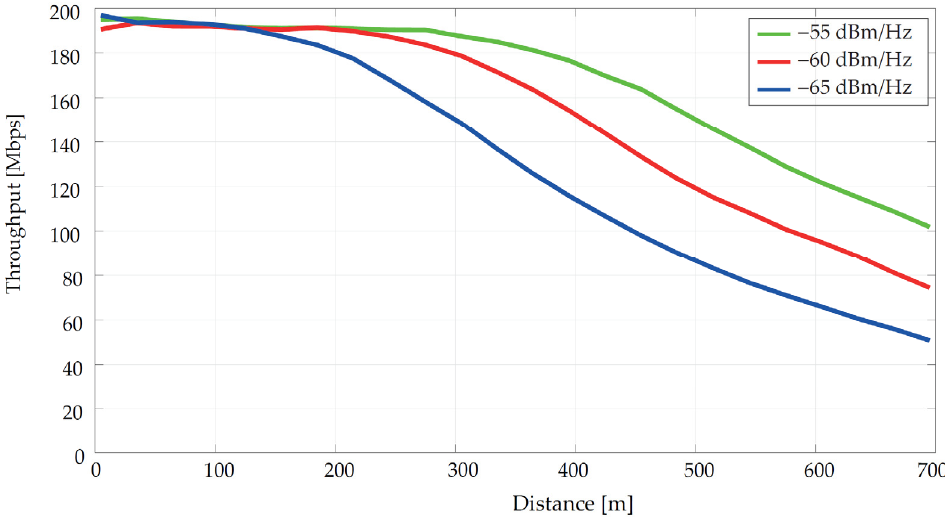
Figure 4. Dependence of transmission speed on distance at different power values.